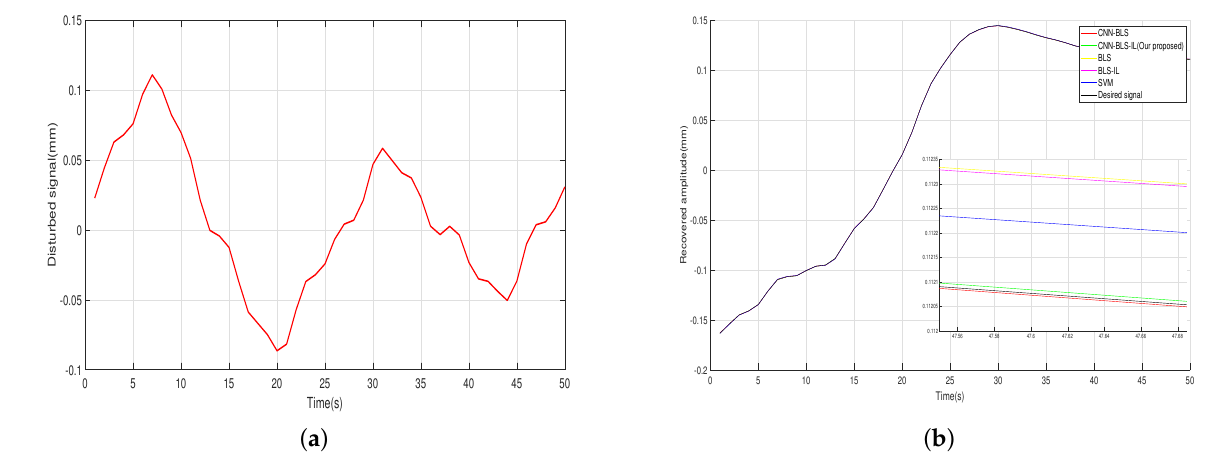
Figure 13. The trajectory with tremor and the effect of tremor attenuation. ( a ) The signal with small amplitude and high − low frequency tremors. ( b ) Tremor attenuation performance of different algorithms in the case of tremors with small amplitude and high − low frequency. Table 3. Compare among evaluation results with different methods: SSE; RMSE; R2; Time. Methods and